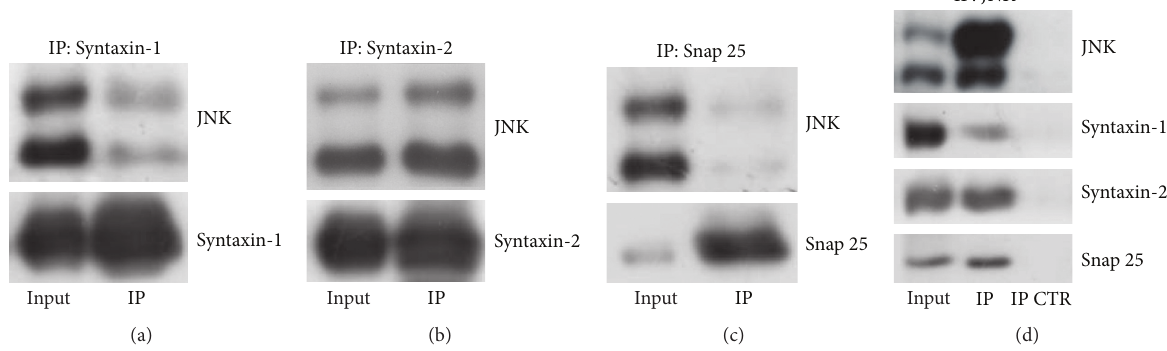
Figure4:JNKpreferentiallyinteractswithSyntaxin-1,Syntaxin-2,andSnap25.(a–c)WesternblottingafterimmunoprecipitationofSyntaxin- 1 (a), Syntaxin-2 (b), and Snap25 (c) on purified synaptosomes lysates extracted from adult mice cortex. JNK is detectable in Syntaxin-1 and Syntaxin-2 precipitate, while immunoreactive signal is weak in Snap25 precipitate. (d) Both Syntaxin-1 and Syntaxin-2, as well as Snap25, were detectable in JNK precipitate. 500 𝜇 g of total lysates has been subjected to immunoprecipitation, while 20 𝜇 g was loaded as control. 𝑁 = 4 .